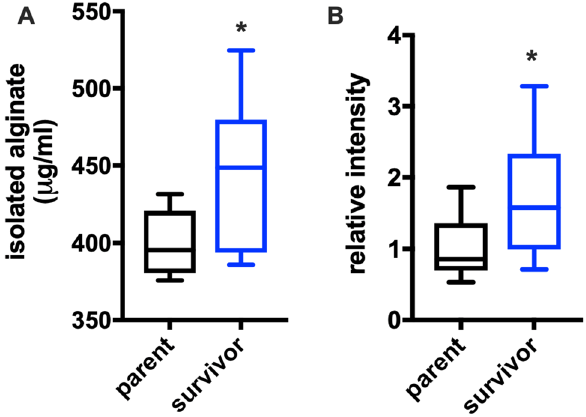
Figure 7. Increased alginate production from survivor P. putida . ( A ) Isolated alginate concentration determined from carbazole assays depicting increased alginate production observed from survivor P. putida (n = 16; p ≤ 0.02). ( B ) Relative intensities of alginate dot blots generated from isolated alginate also depicting increased alginate production observed from survivor P. putida (n = 10; p = 0.039). Relative units determined from average of control values with statistical significance calculated from an unpaired t test with Welch’s